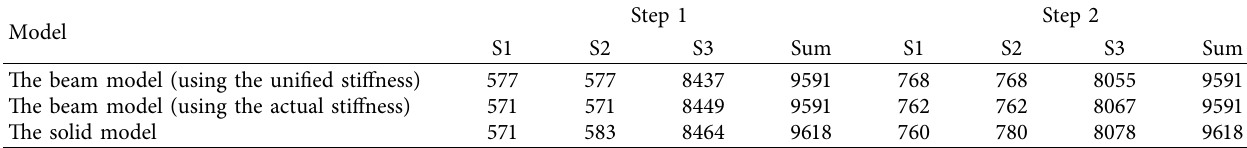
Table 2: Vertical reactions in the first two steps from two beam models and the solid model (unit: kN). Model